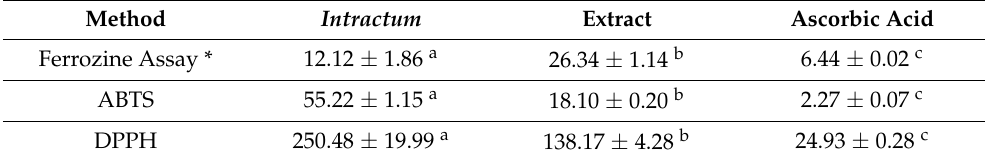
Table 2. Antioxidant activity of the intractum and extract, EC 50 value presented as [ µ g/mL]. * % Chelating of iron was presented in %. Ascorbic acid was used as a reference substance. Different superscript letters within the same row indicate statistically significant differences with p <